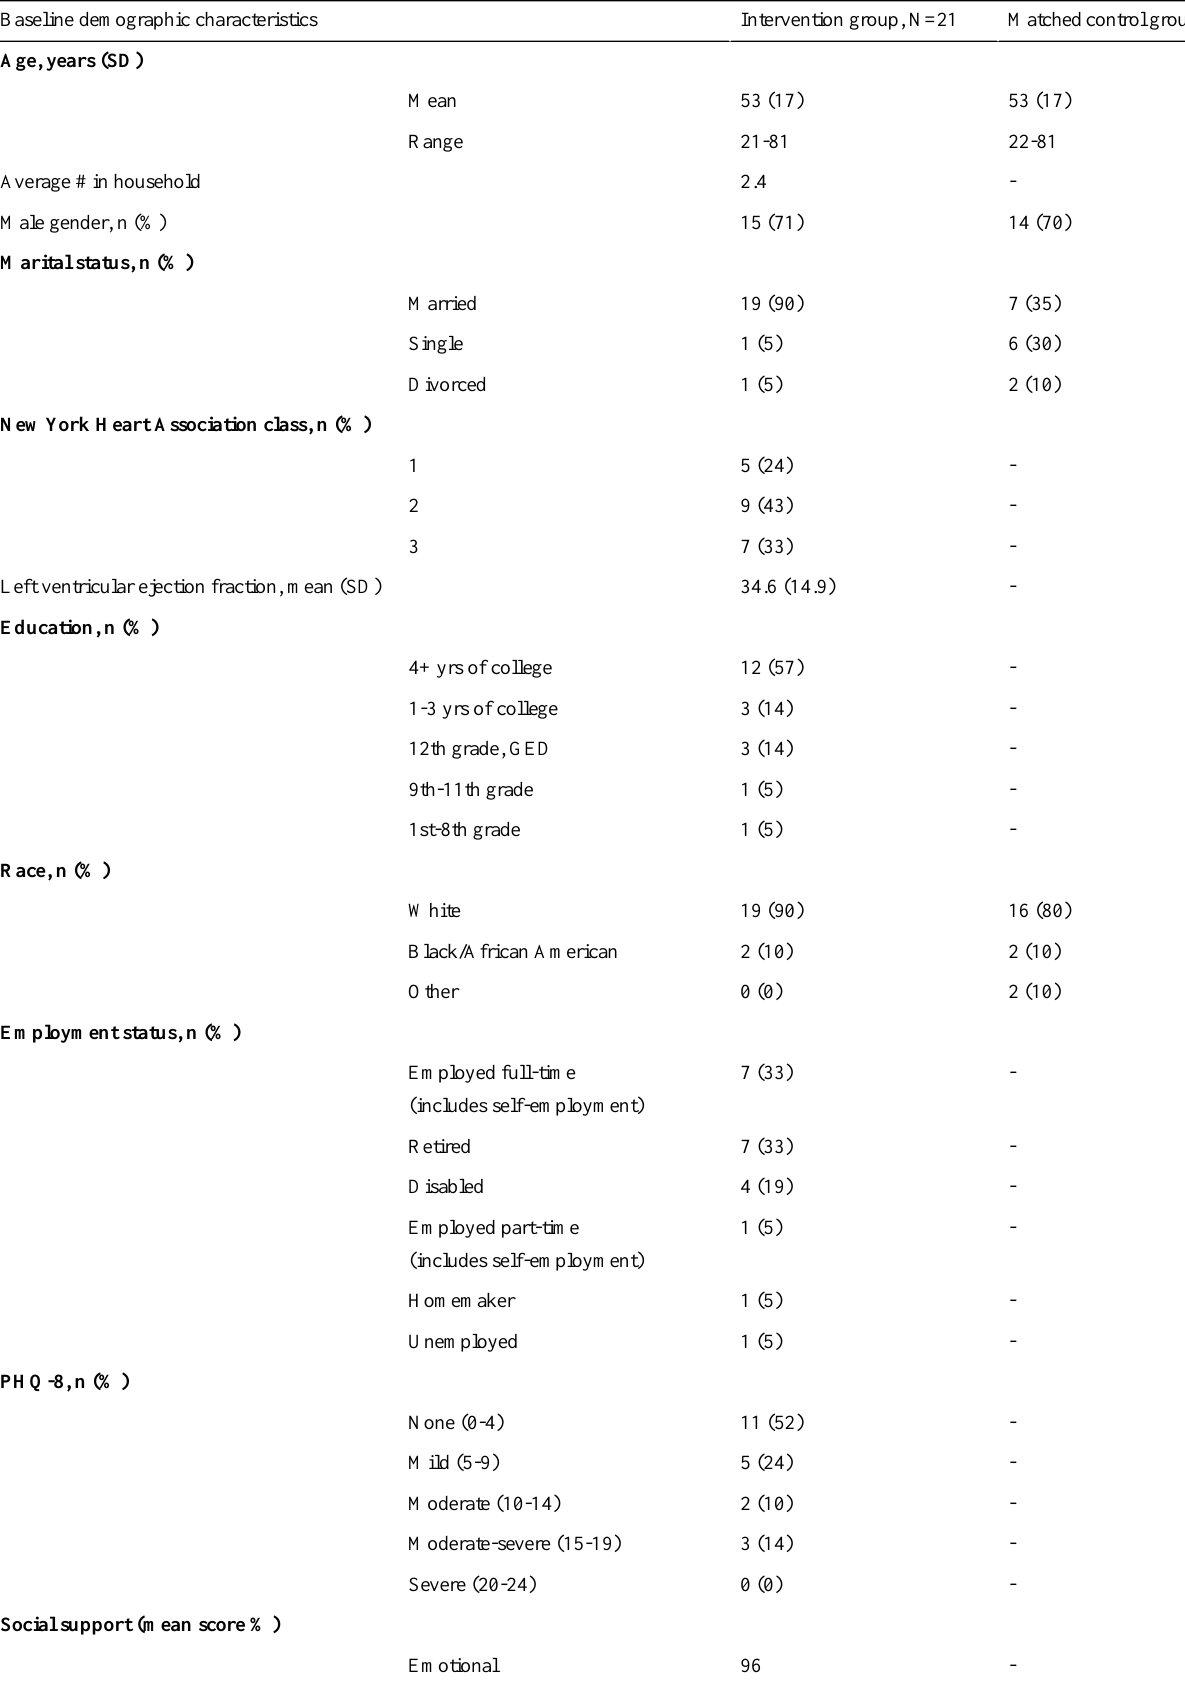
Table 1. Baseline demographic characteristics of study